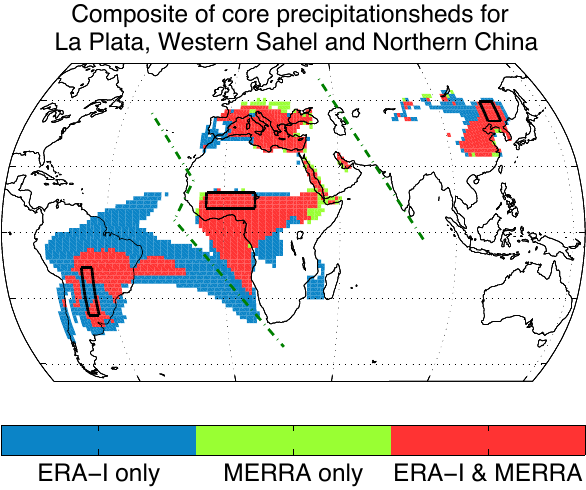
Figure 5. Comparison of core precipitationshed extents for ERA-Interim and MERRA results, for the period 1980–2011, using the >5mmgrowingseason − 1 boundary and 100% occurrence. The dashed green lines are meant to visually separate the different pre- cipitationsheds. Note that, where the core precipitationshed bound- aries for the western Sahel and La Plata basin overlap (particularly in the South Atlantic), the values for the western Sahel are dis- played. Also, the Mediterranean sources belong to the western Sahel